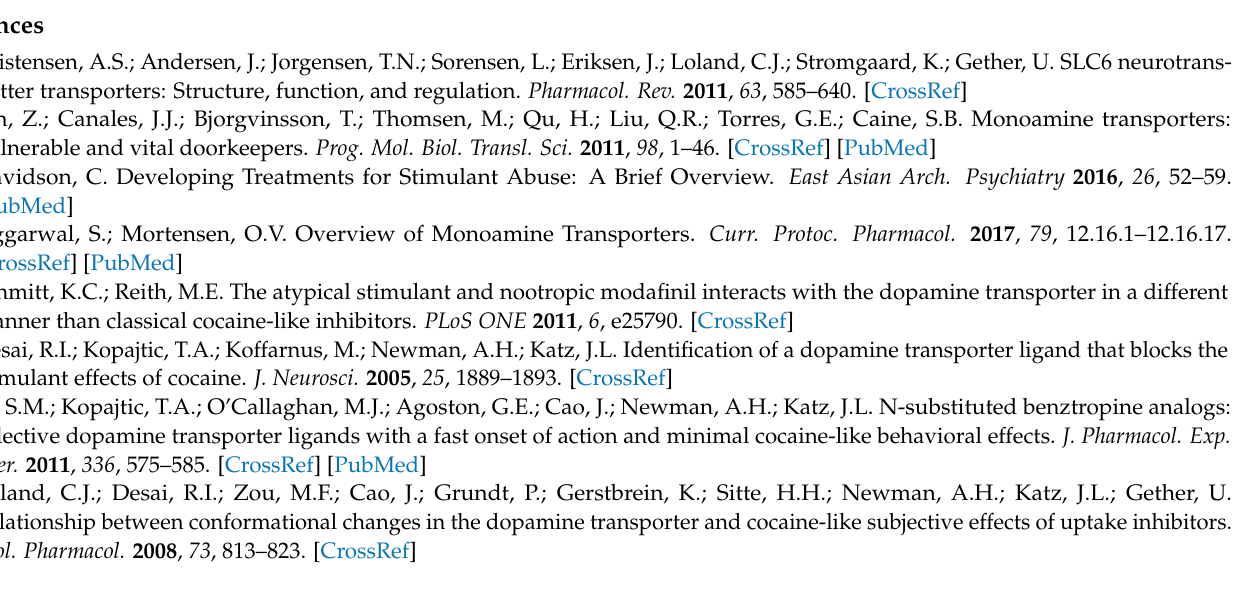
closest atom–atom distance) between DAT and sydnocarb (indicated by orange-shaded areas) with the binding frequency summarized by the horizontal blue bars on the right panel. (C,G) Sydnocarb- binding poses captured in simulations with a snapshot taken every 4 ns. The ligand conformations are shown in cyan sticks. (D,H) MD-resolved final poses of sydnocarb (light orange vDW) observed at the end of the MD simulation in Run3 and Run4. Results for MD Run1 and Run2 can be found in Figure 3. Figure S4: MD simulations of KM822 binding to hDAT. Top (A–D) and bottom (E–H) boxes display the results from two independent runs: KM822-Run1 and KM822-Run2. (A,E) KM822 diffusion as a function of time estimated by the RMSD of KM822 atoms with respect to the final pose at 150 ns. (B,F) Time evolution of contacts (< 4.0 Å closest atom–atom distance) between DAT and KM822 (indicated by orange-shaded areas), with the binding frequency summarized by the horizontal light orange bars on the right panel. (C) Representative Run1-Site-binding pose of KM822 (vDW), captured transitionally in KM822-Run1. (D,H) MD-resolved final poses of KM822 (vDW) observed at the end of KM822-Run1 and KM822-Run2. White, cyan, blue, red, and yellow spheres represent hydrogen, carbon, nitrogen, oxygen, and sulfur atoms, respectively, in KM822. (G) KM822-binding poses captured in the simulation KM822-Run2 with a snapshot taken every 4 ns. The ligand conformations are shown in cyan sticks. Figure S5: (A) Binding sites are shown in green, red, and blue surfaces for the substrate-binding site, allosteric sites, Run1-Site (Site I), and A2 (Site II), respectively. (B) Same binding sites are illustrated in green, red, and blue sticks for the residues composed of the substrate-binding site, allosteric sits, Run1-Site (Site I), and A2 (Site II), respectively. Run1-Site (Site I) is displayed in red for residues commonly bound to sydnocarb. A2 (Site II) is shown in blue for residues commonly bound to KM822 and sydnocarb. Some residues, such as W84/R85 and D476/H477, are shared between the two allosteric sites. Substrate-binding site-composed residues in green are obtained from the previous simulations of cocaine binding to OF o DAT [38]. (C) Representative binding poses of the ligand to the two sites shown in (B). Green, red, and blue vDW balls represent cocaine, sydnocarb in the Run1-Site, and KM822 in the A2